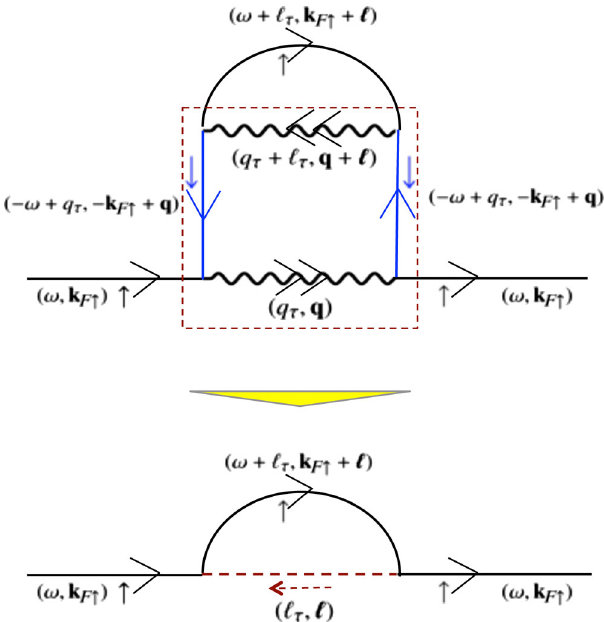
FIG. 4. Repeated scattering of Cooperons and particle-hole pairs of cold, off-shell fermions (red, dashed box in upper graph) mediates a singular, intraspecies interaction (red, dashed line in bottom graph) that induces non-Fermi-liquid behavior on the Fermi surfaces. Wiggly lines here denote the one-loop dressed (cf. Fig. 9) Cooper pair